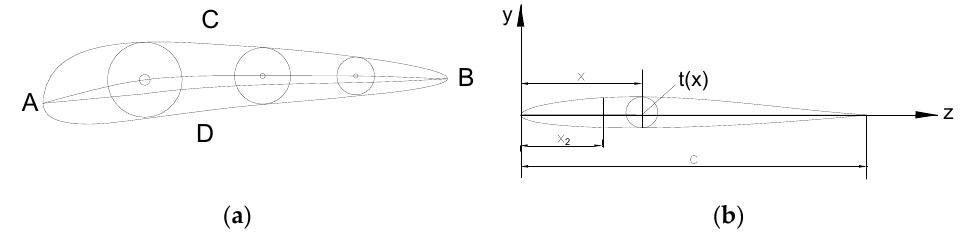
Figure 4. ( a ) The chord of airfoil. ( b ) The thickness of the airfoil.